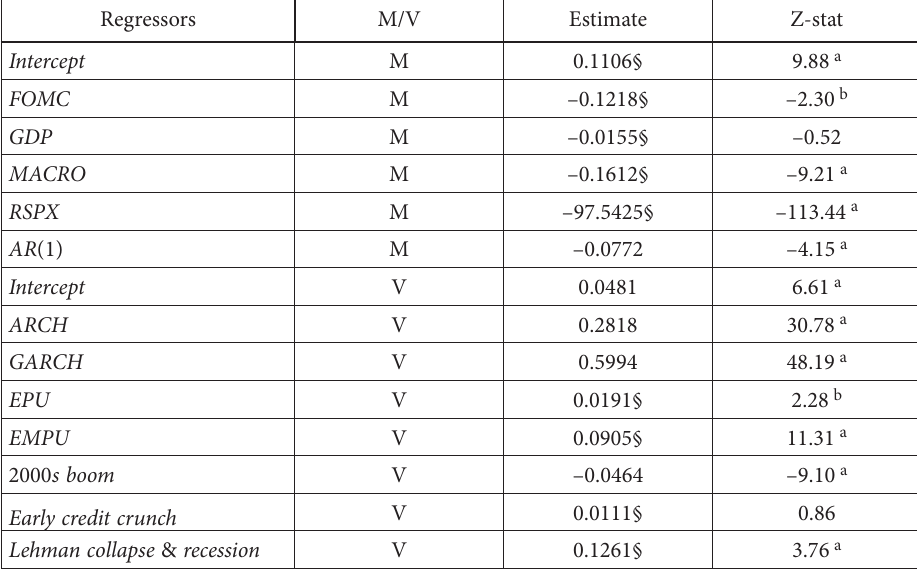
Table 4. Economic policy uncertainty and the implied volatility index